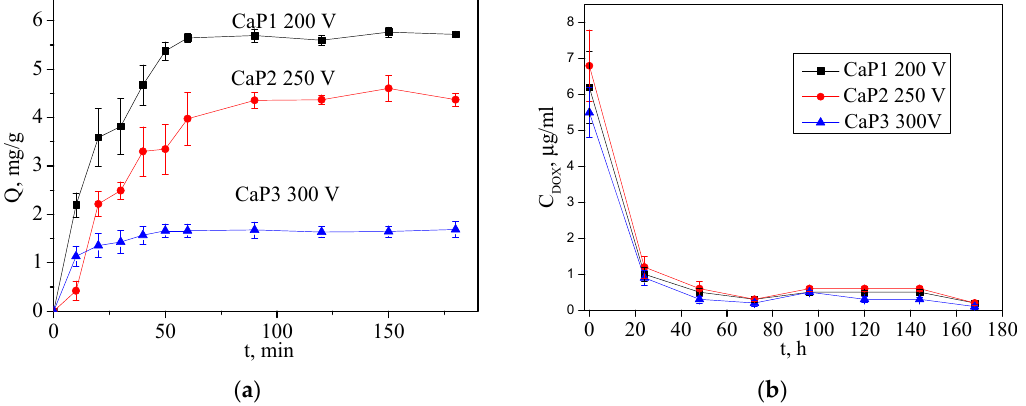
Figure 8. Kinetic curves of the adsorption ( a ) and desorption ( b ) of DOX by the samples of CaP coatings synthesized at different voltages of the MAO process.